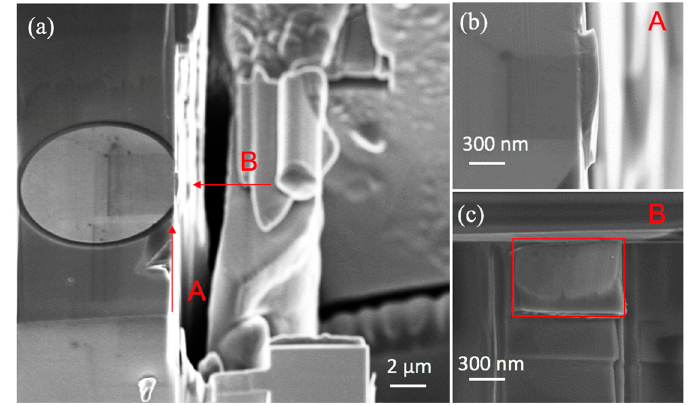
Figure 6. ( a ) SEM images of post-failure of cantilever beam, ( b ) top view details, ( c ) interfacial details